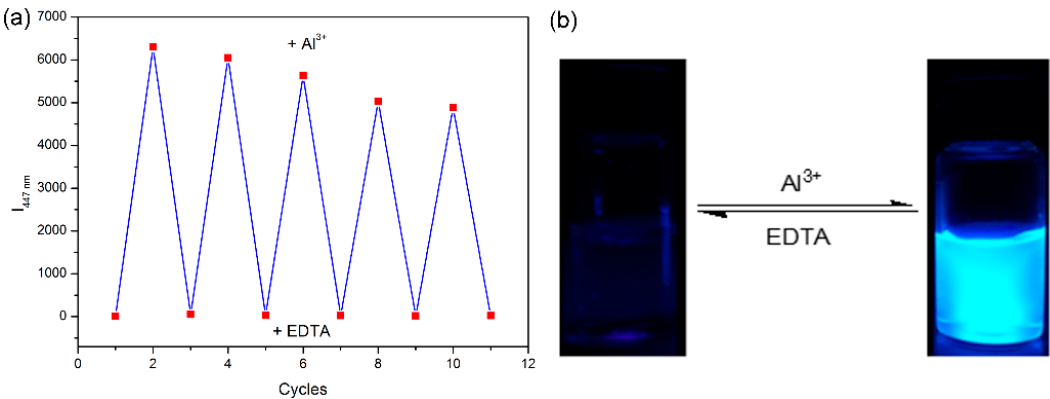
Figure 6. ( a ) Reversible switching cycles of fluorescence intensity at 447 nm by alternate addition of Al 3+ (1 equiv.) and EDTA (1 equiv.) in aqueous solution of PEGBAB (10 μ M). ( b ) Reversible fluorescence changes of PEGBAB (10 μ M) in aqueous solution by alternate addition of Al 3+ (1 equiv.) and EDTA (1 equiv.).